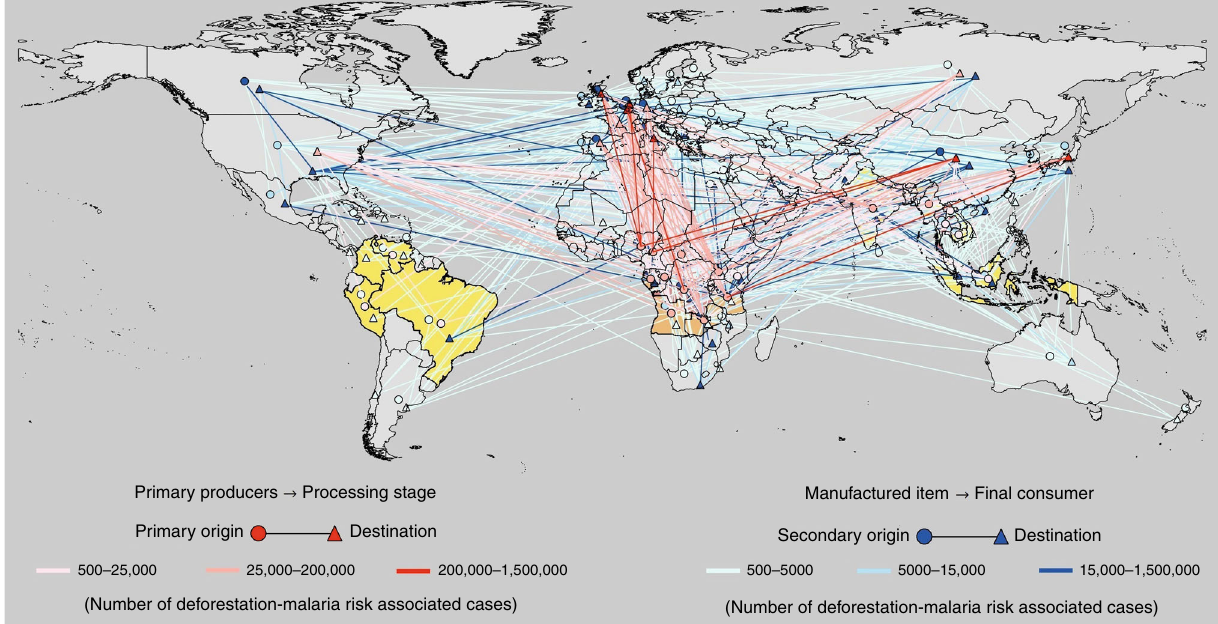
Fig. 3 International trade routes of malaria risk associated with traded commodities. Countries with populations at risk are shaded as in Fig. 1. Trade relationships are color-coded, with risk categories falling into three range brackets. A bracket [500-25,000] means that the respective shade of red is used for lines representing the estimated number malaria risk cases. We distinguish ( a ) primary trade routes (red) that originate in countries where deforestation causes malaria risk, and end in countries where commodities are manufactured and assembled for fi nal sale, followed by ( b ) secondary trade routes (blue) that end in countries where commodities are fi nally consumed by households. Software used: QGIS version 2.8 without any changes. QGIS